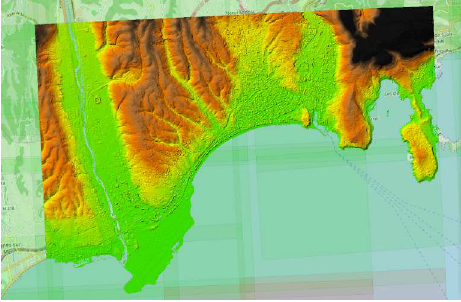
Figure 6: DSM of Nice generated in unit tests